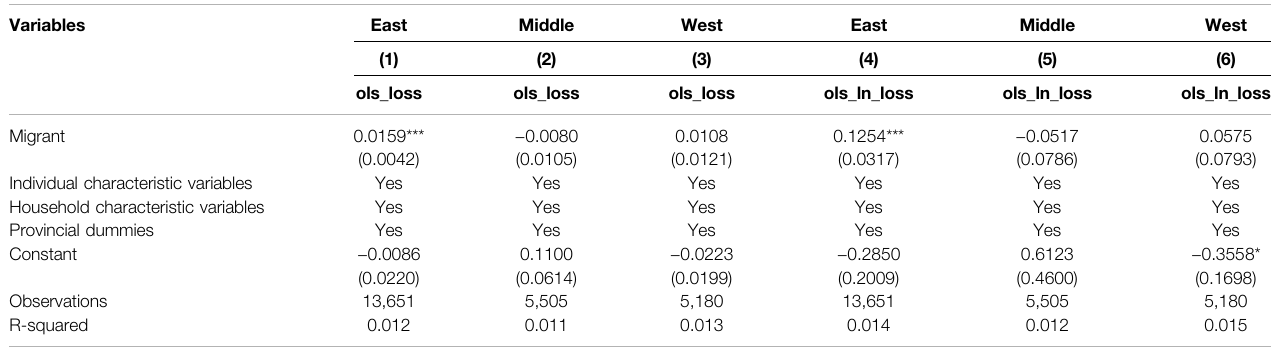
TABLE 4 | The regression of risk of households being defrauded on migrant grouped by region.